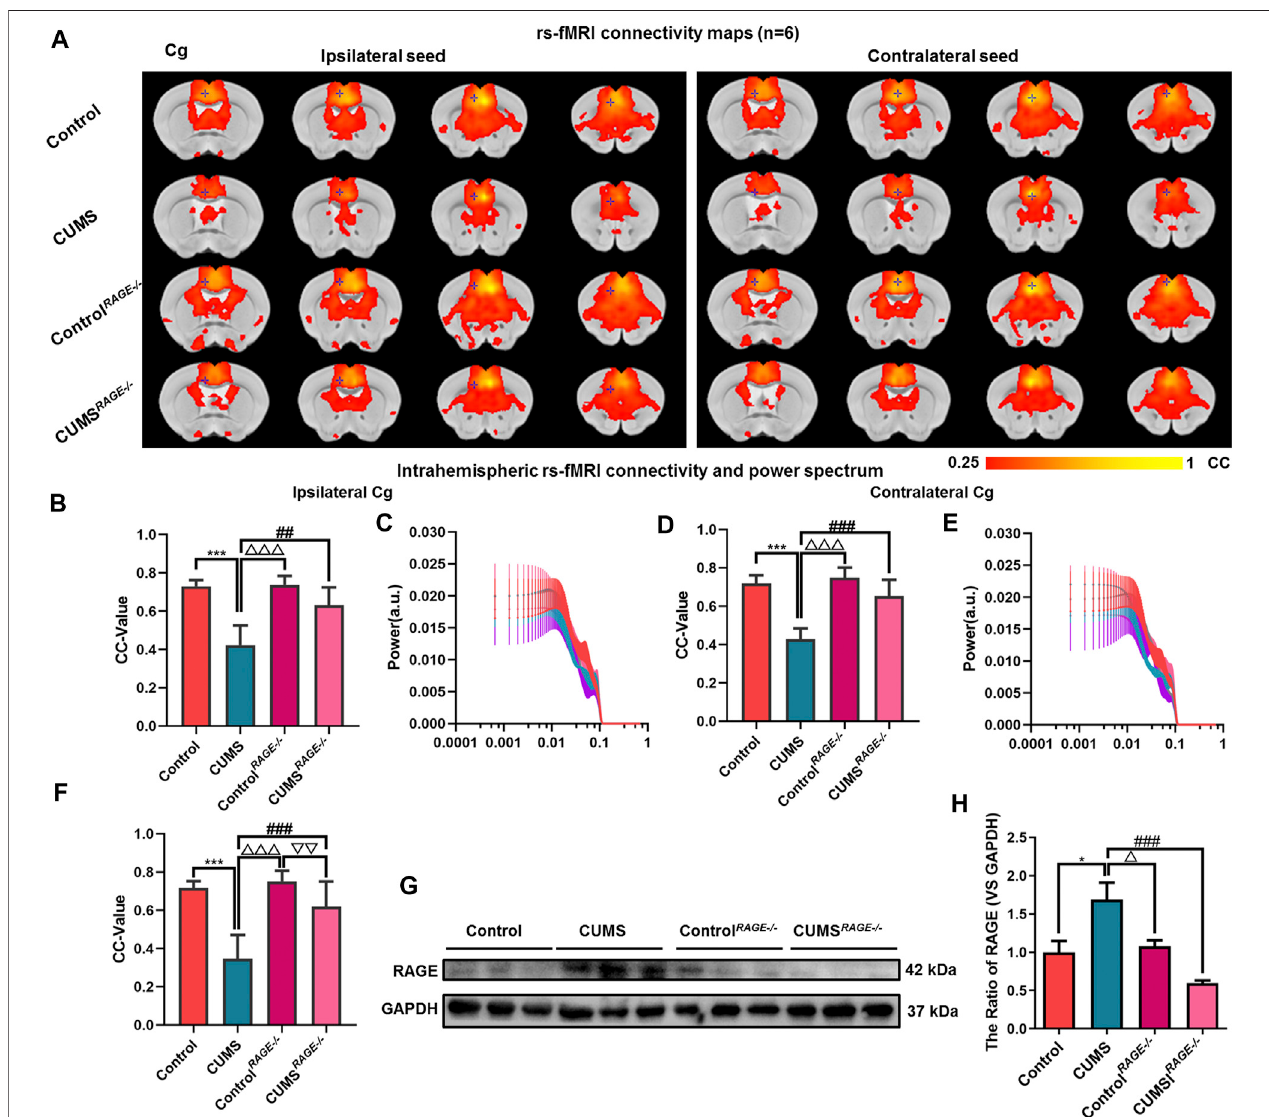
FIGURE4| EffectofRAGEknockoutonbrainfunctionalconnectivityindepressive-likemiceinducedbychronicstress. (A,F) Rs-fMRIconnectivitymapsoftheCg in four groups of mice (A) , corresponding quanti fi cation of interhemispheric connectivity (F) . (B – E) Quanti fi cation of intrahemispheric rs-fMRI connectivity (B, D) and the respective power spectrum (C, E) of ipsilateral and contralateral Cg in four groups of mice. (G – H) Western blot and semi-quantitative results of RAGE in the Cg of mice. Thedataarepresentedasmean ± SEM.One-wayANOVAfollowedbyBonferroni ’ s posthoc test;* p < 0.05and*** p < 0.001,CUMSgroupvs.Controlgroup; ## p < 0.01, ### p < 0.001, CUMS group vs. CUMS RAGE − / − group; △ p < 0.05, △△△ p < 0.001, CUMS group vs. Control RAGE − / − group; ▽▽ p < 0.01, CUMS RAGE − / − group vs. Control RAGE − / −